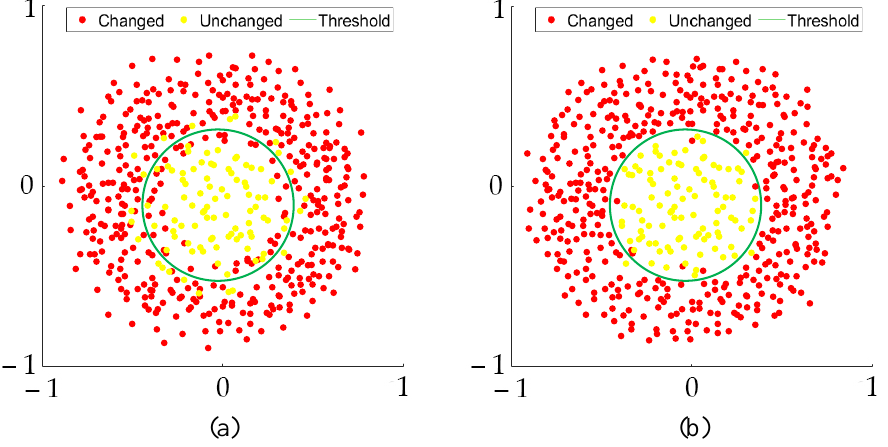
Figure 3. Demonstration of pixel distribution ( a ) before L-SFA, and ( b ) after L-SFA. To solve the L-SFA problem, the following (7) – (9) are used. The core of L-SFA is the objective function and its three constraints [20]. In this case, the algebraic mapping results in a generalized eigenproblem as (7).